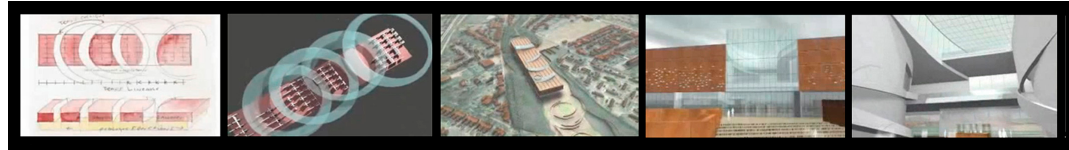
Figure 5. Steven Holl, Musée du Louvre-Lens. Movie by Neutral (4:00), 2005.